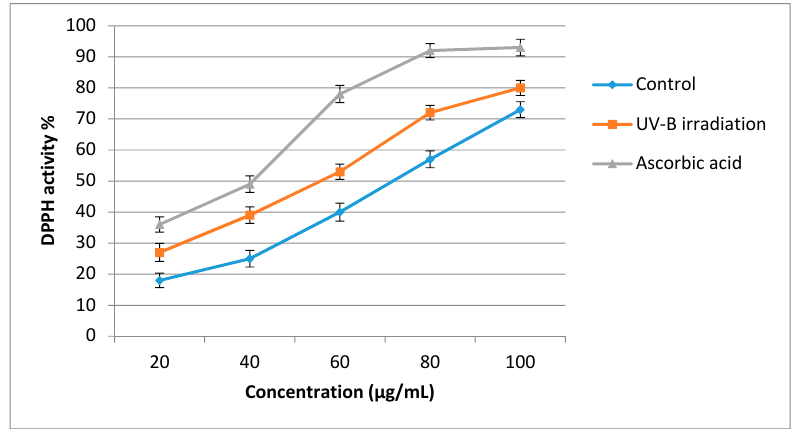
Figure 2. Antioxidant activity of sweet basil non-treated leaves and UV-B treated (3.60 W/m 2 , 8-h) leaves using DPPH assay. Bars represent standard errors of the means.